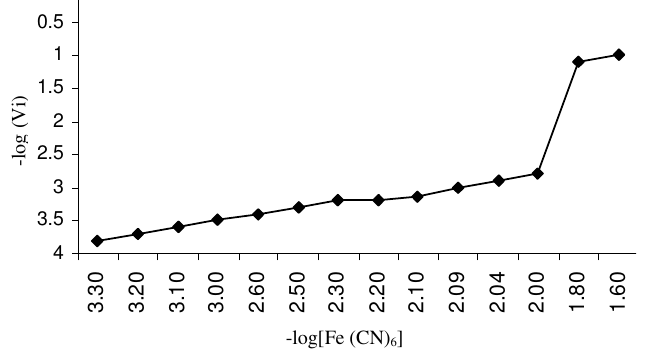
Figure 4 . Dependence of the initial rate on [Fe(CN) 64- ] in presence of [Hg 2+ ] at [EDTA] 3 x 10 -4 M, [Hg 2+ ] = 3 x 10 -5 M, pH 5.0, temp = 25 0 C and 0.2 M (KNO